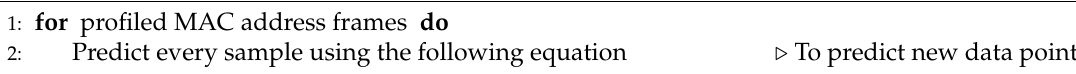
Algorithm 2 Detection